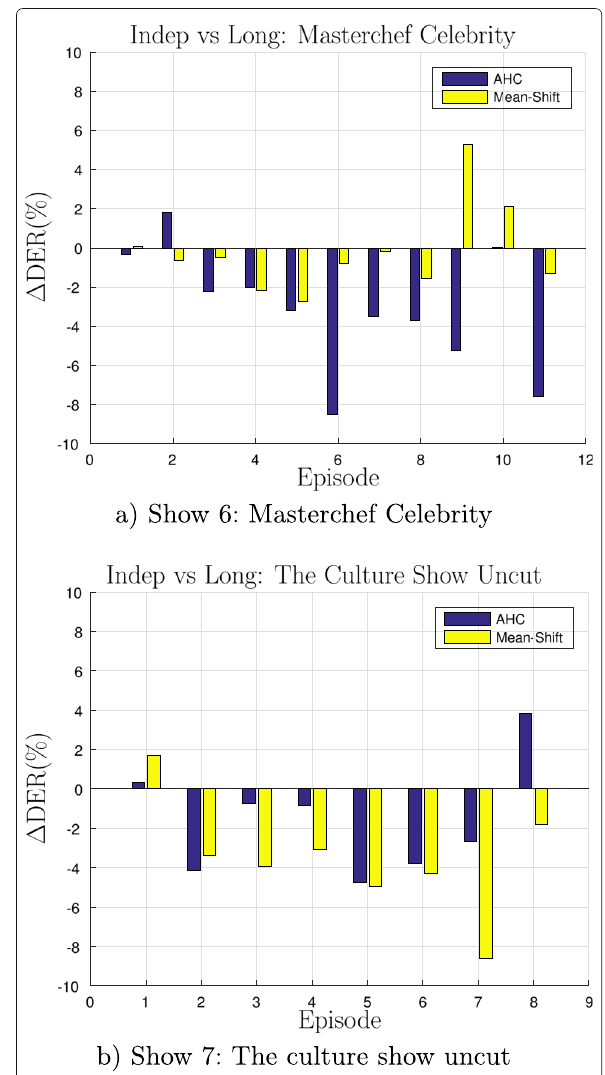
Fig. 12 (cid:2) DER (%) performance episode by episode for the two shows of the evaluation set. Defined as (cid:2) DER = ( DER INDEP − DER LONG ) . AHC refers to the agglomerative clustering pseudo-speaker labels. a Show 6: Masterchef celebrity. b Show 7: The culture show uncut